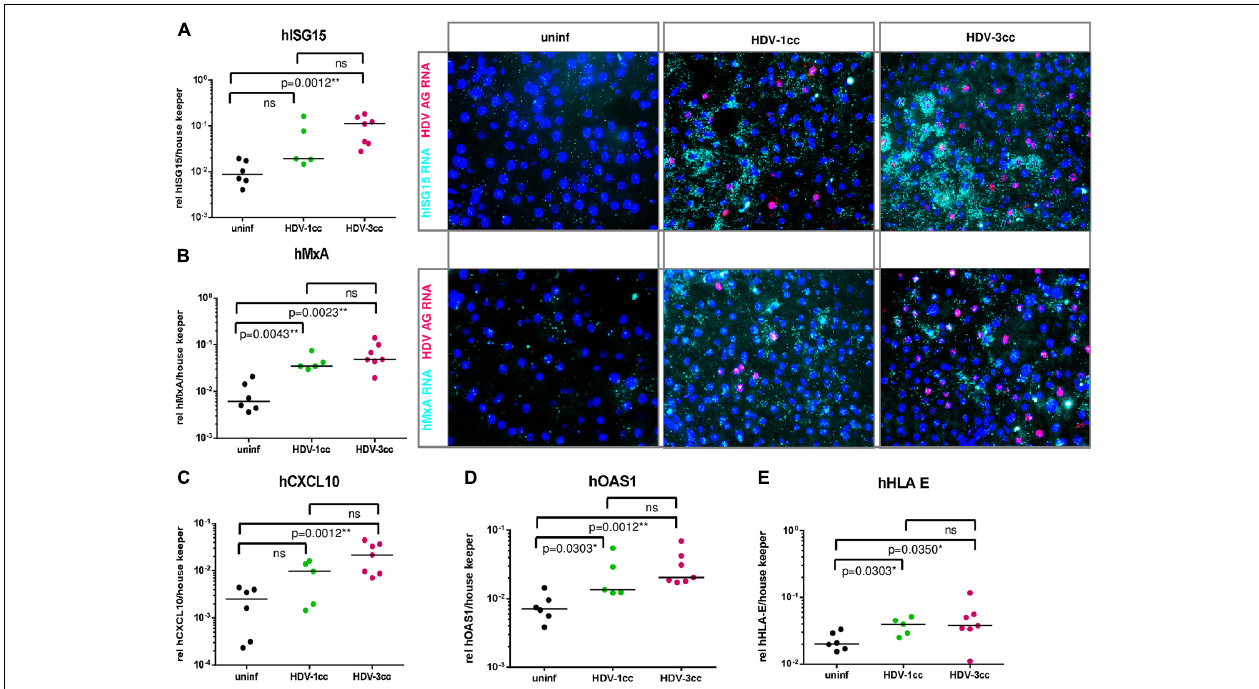
FIGURE 3 | Human specific ISGs and chemokines in mice co-infected with HBV and HDV-1cc or HDV-3cc. (A–E) qRT-PCR measurements (normalized to median of housekeeping genes hGAPDH and hRPL30) (A left, B left, and C–E) and RNA in situ hybridization staining (A right, B right) of human ISG15 (A) , MxA (B) , CXCL10 (C) , OAS1 (D) , and HLA-E (E) in livers of HBV/HDV-1cc and HBV/HDV-3cc co-infected mice 9 weeks post infection compared to uninfected mice. The bar shows median levels. * p < 0.05, ** p < 0.01. RNA in situ hybridization stainings show hISG15 RNA and hMxA RNA in aqua and HDV AG RNA in red. Nuclei are stained with dapi